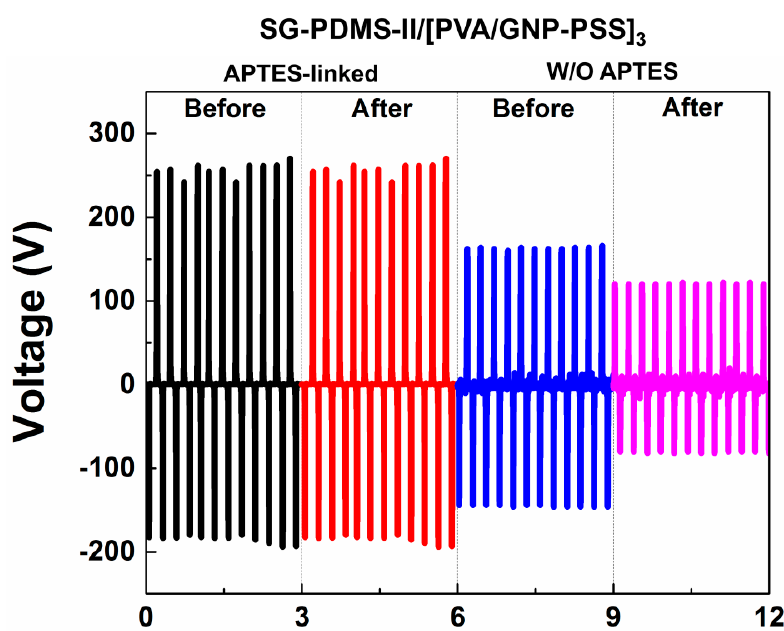
Figure 7. Triboelectric output voltage of SG-PDMS-II@[PVA/GNP-PSS] 3 TENG with and without an APTES linker before and after 10,000 bending cycles.